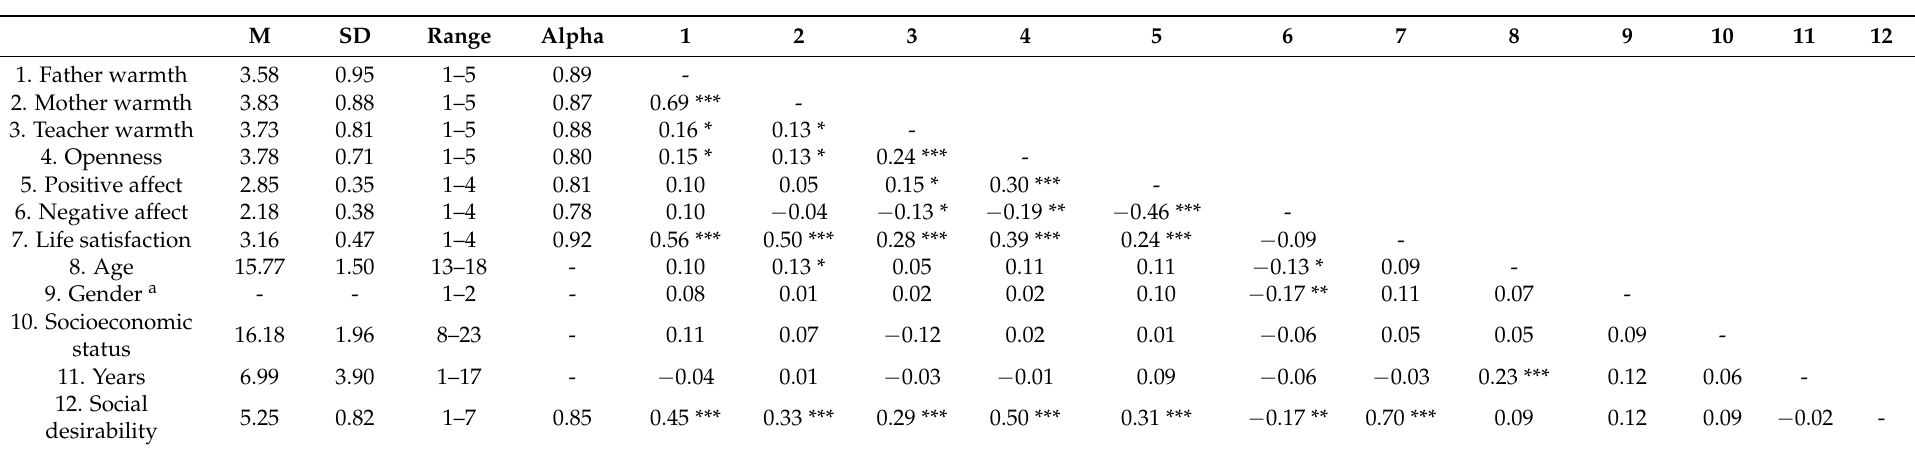
Table 1. Descriptive statistics and intercorrelations among variables for left-behind youth.